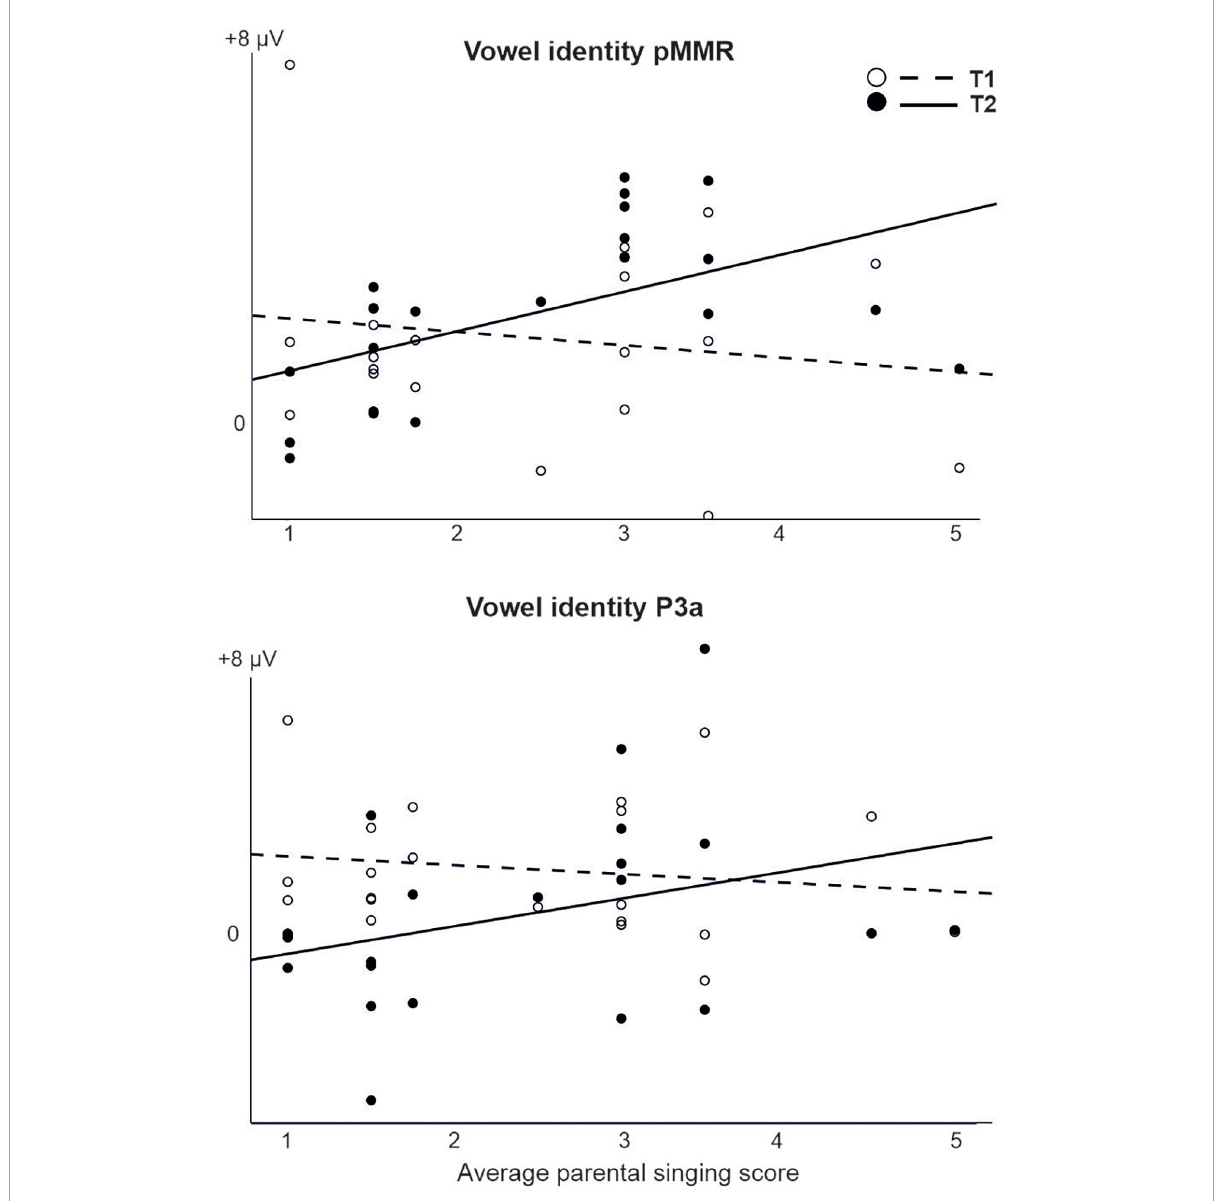
FIGURE5 The interaction of parental singing and pMMR (upper figure) and P3a (lower figure) at time points of measurement T1 and T2 in the CI group as found in the LMM. Parental singing is a combination of the assessments by the parents themselves on a 1–5 Likert scale at T1 and T2. Note the intersection of the illustrative regression lines, which pinpoints the level of parental singing where the responses are approximately of equal size at T1 and T2. Thus, for the pMMR, singing increases the response size from T1 to T2 from an approximate singing level = 2, and for the P3a, singing sustains the size of P3a from T1 to T2 from an approximate singing level =